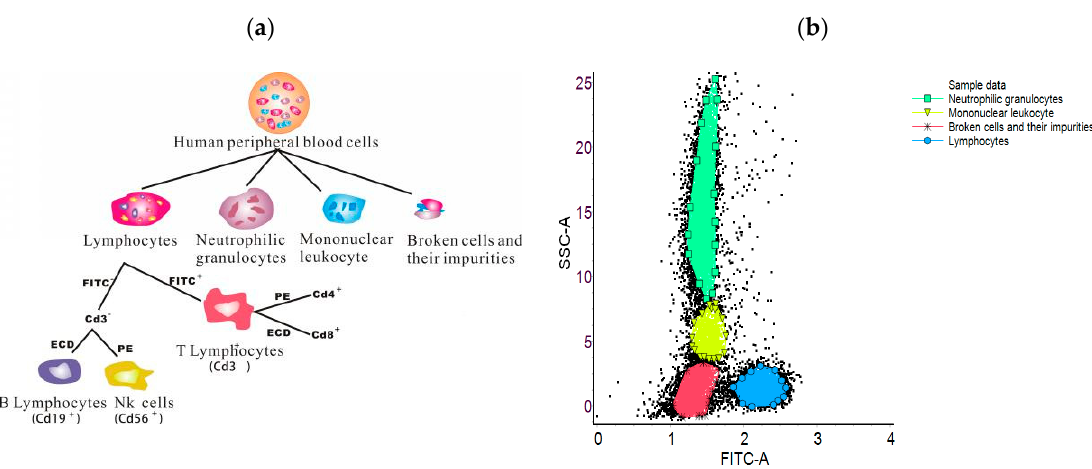
Figure 5. Experimental control group ( a ) Cell staining strategy; ( b ) Artificial clustering results.